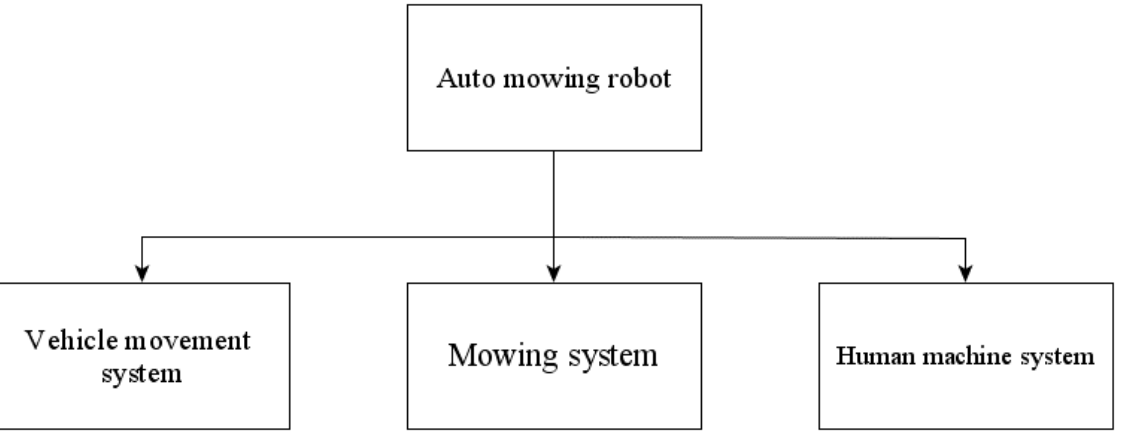
Figure 1. System architecture of the automatic robotic lawn mower.